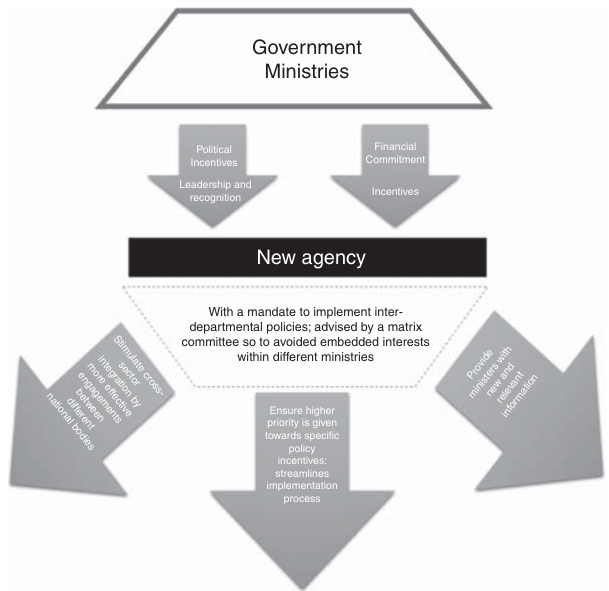
Figure 2. Governmental structure for effective implementation of cross-sectoral